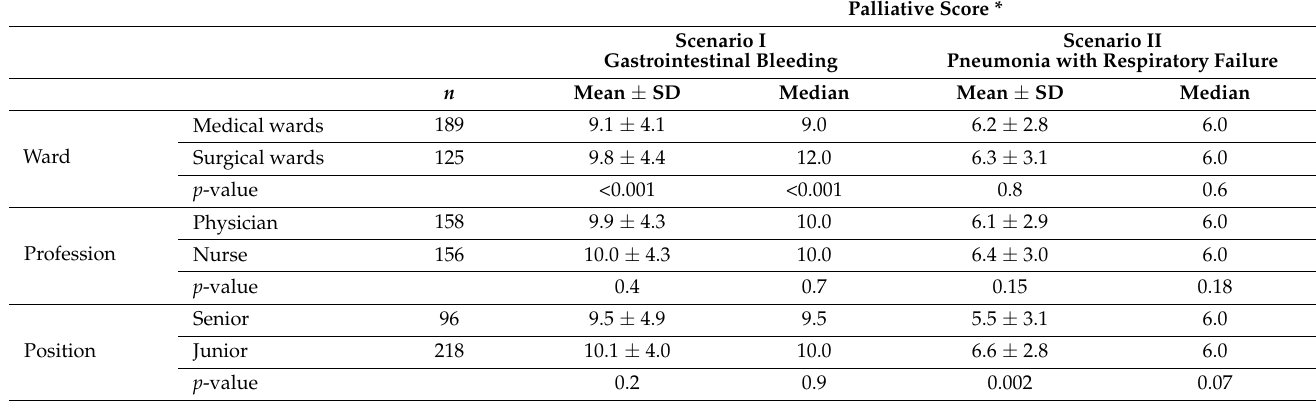
Table 3. Palliative Scores in the two hypothetical scenarios according to participants’ characteristics ( n = 314). Palliative Score * Scenario I Scenario II Gastrointestinal Bleeding Pneumonia with Respiratory Failure n Mean ± SD Median Mean ± SD